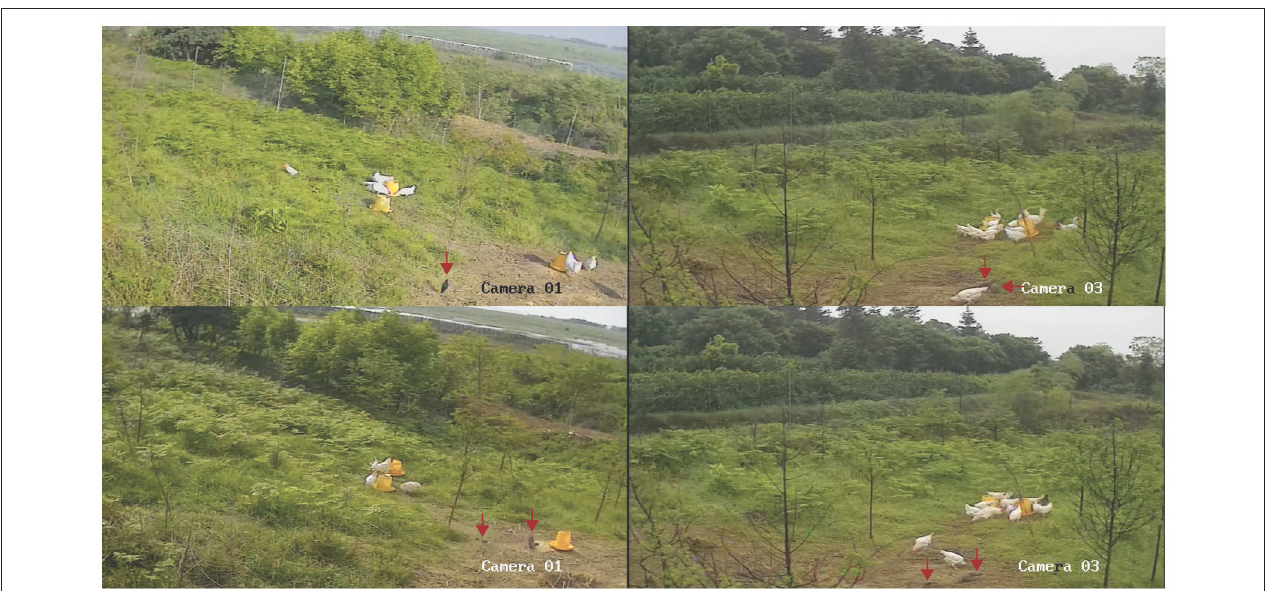
HA protein were observed, which is proposed to enhance binding capacity of human like receptors and mammalian